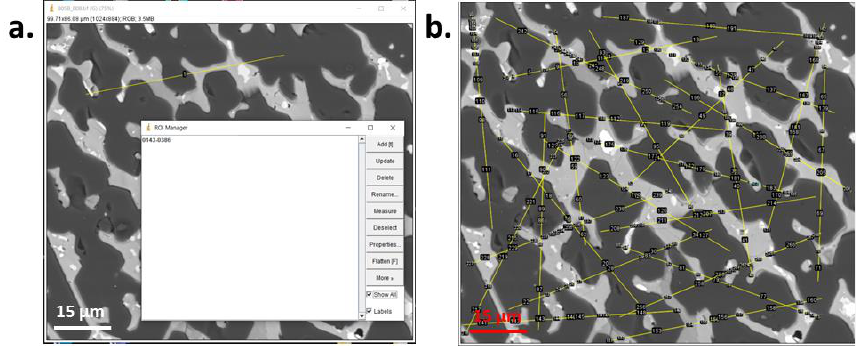
Figure 11. Windows of ImageJ during the linear analysis of the image, ( a ) using ROI Manager for adding the secants and chords, ( b ) with all secants and chords.